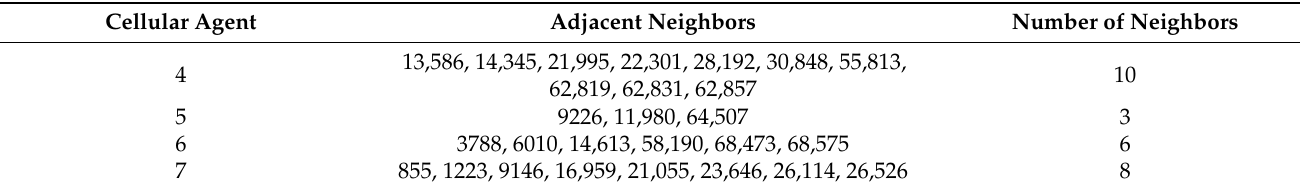
Table 3. An example of cellular agents and their adjacent neighbors after implementing the neighbor tool. Cellular